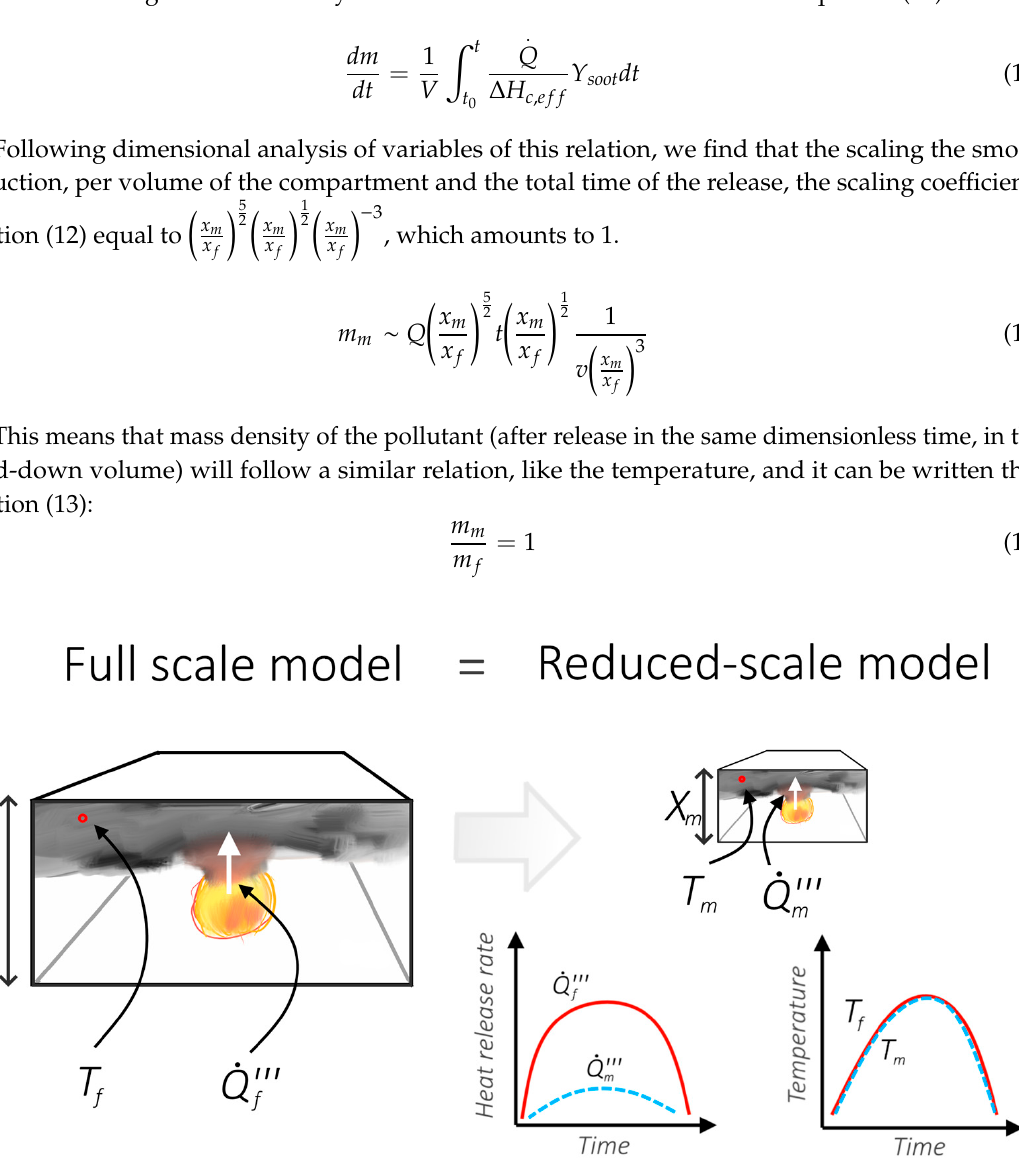
Figure 2. The idea of the Froude number reduced-scale fire modelling. Illustrating the concept of scaling down the heat release rate of the fire to model a fire, that causes similar consequences in the scaled-down (geometrical) compartment.